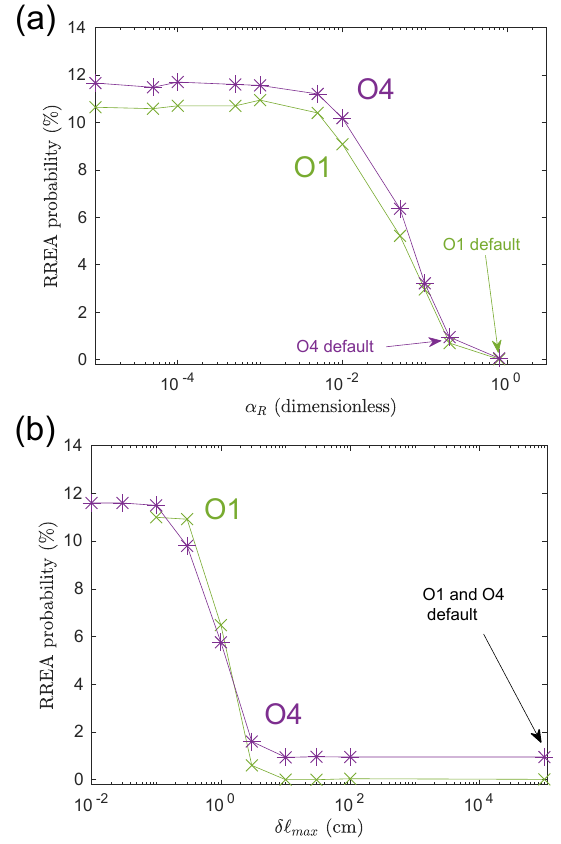
Figure 1. Relativistic avalanches probabilities calculated from Geant4 simulations for a specific point { (cid:15) = 75keV , E = 0 . 80MVm − 1 } (illustrated by a cross in Fig. 2) and for two stepping settings. (a) Avalanche probability versus α R setting for Geant4 O4 and Geant4 O1. δ(cid:96) max is set to the default value of 1km. (b) Avalanche probability versus maximum step setting ( δ(cid:96) max ) for Geant4 O4 and Geant4 O1. The parameter α R is set to the default value of the models, which is 0.8 for O1 and 0.2 for